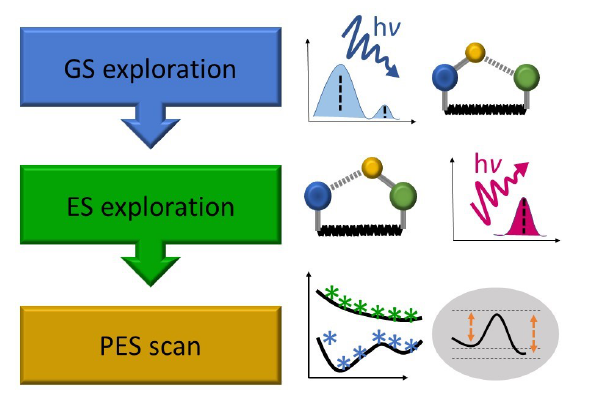
Figure 2. Typical workflow of the static ESIPT investigation